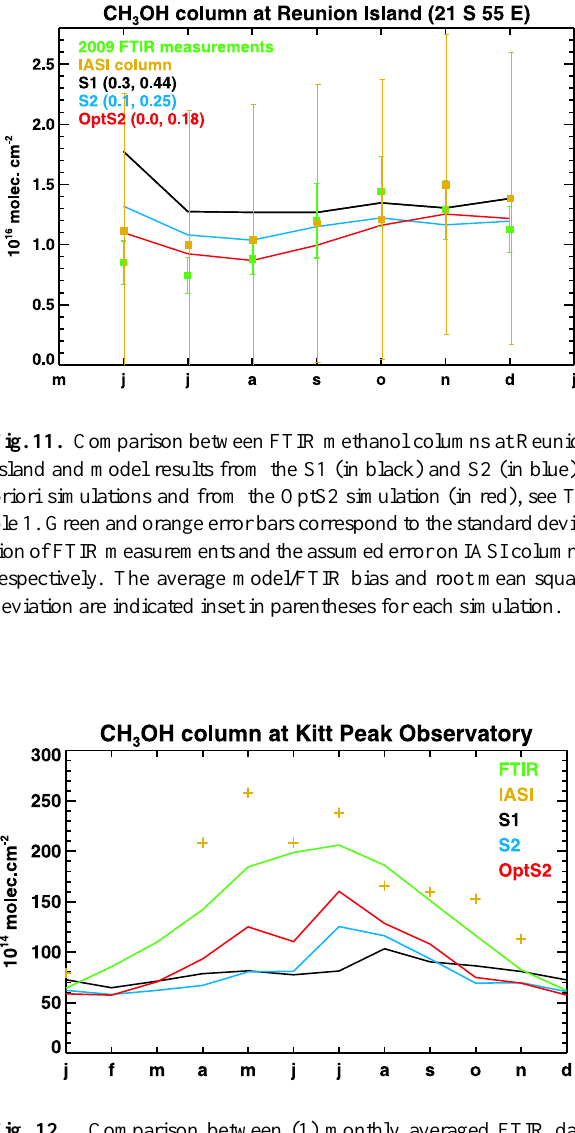
cob et al. (2005) might not be adequate for tropical regions, both in terms of seasonality and magnitude. Over Europe, the S2 run results in a moderate underestimation and to a less marked seasonal cycle compared to IASI (Fig.